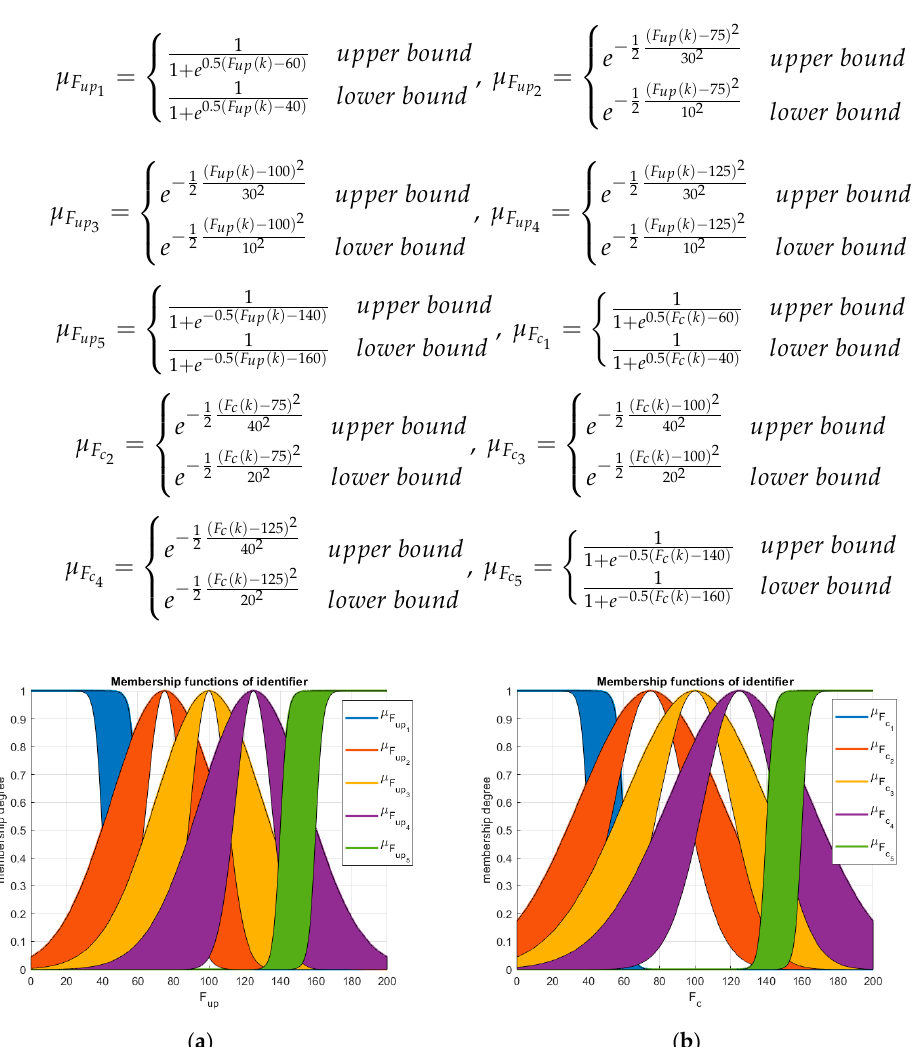
μ and μ . ( a ) The membership function and µ F . ( a ) The membership function µ F up c up F c F μ . c c F